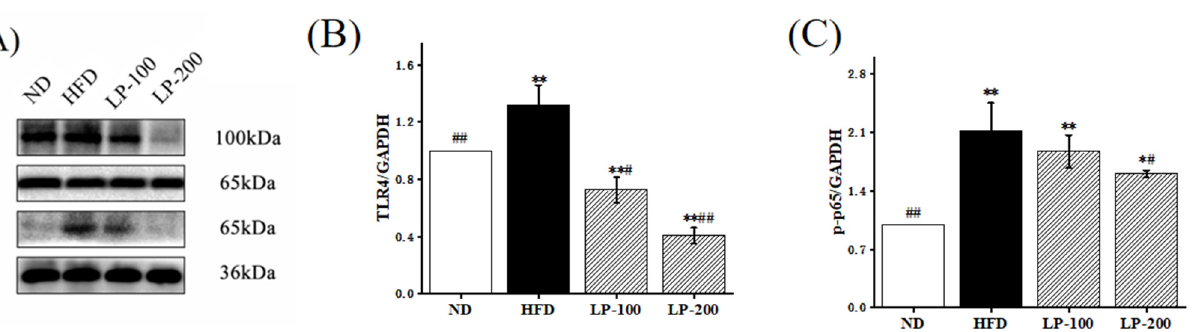
Figure 3. Effect of LPs on TLR4/NF- κ B inflammatory pathway in HFD-fed mice. ( A – C ) Western blot. The expression levels of TLR4, p65, and p-p65 proteins in the renal lysates of mice fed with CD, CD+HFD, and CD+HFD+LPs. The signal intensity was quantitatively analyzed. * p < 0.05, ** p < 0.01 vs. ND group; # p < 0.05, ## p < 0.01 vs. HFD group.